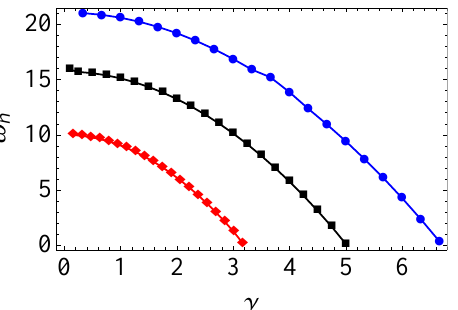
Figure 8. The natural frequency for different ξ 1 with α = 50, p = 0.04, k s = 0.01 fixed, from top to bottom ξ 1 = 0.1,0.5,0.8.